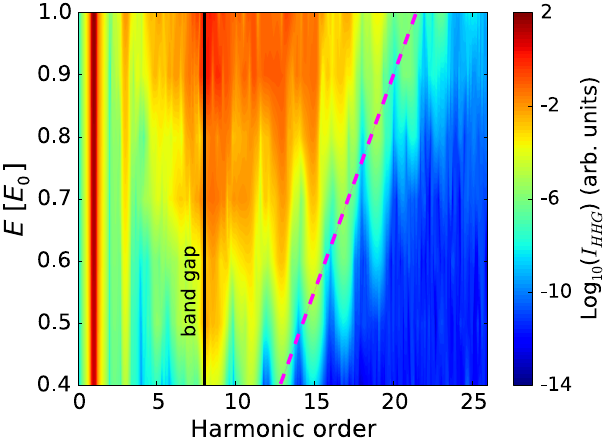
FIG. 5. Harmonic spectra as a function of electric-field strength. The electric-field axis is in units of E 0 ¼ 0 . 0038 a : u : , FIG. 4. (a) Harmonic spectra for different values of the carrier- laser wavelength λ 0 . (b) Same as (a) but with energy units corresponding to the laser intensity I 0 ¼ 5 × 10 11 W = cm 2 . The instead of harmonic order on the frequency axis. The grey line dashed magenta straight line denotes the estimated cutoff of the shows maximum emitted photon energy, which corresponds harmonic spectrum as a function of the electric-field strength. exactly to the maximum energy difference between the con- The carrier-laser wavelength was set to λ 0 ¼ 3 . 0 μ m, laser-pulse 6 eV. Laser intensity was set duction and valence bands, Δ E length to N ¼ 10 laser periods T 0 , and φ vc ¼ to I 0 ¼ 5 × 10 11 W = cm 2 , laser-pulse length to 10 laser periods, calculations are carried out for laser polarization in the Γ − A 0 rad. direction of ZnO and φ CEP ¼